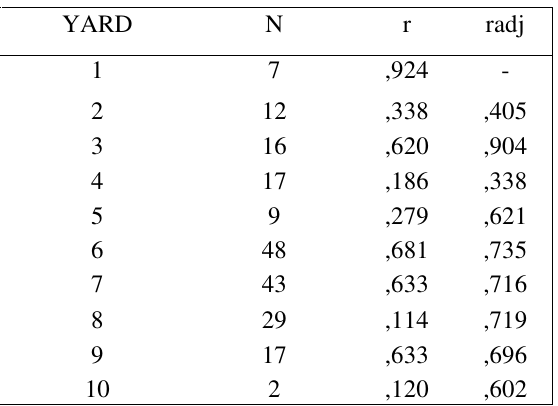
RELIABILITY COEFFICIENTS